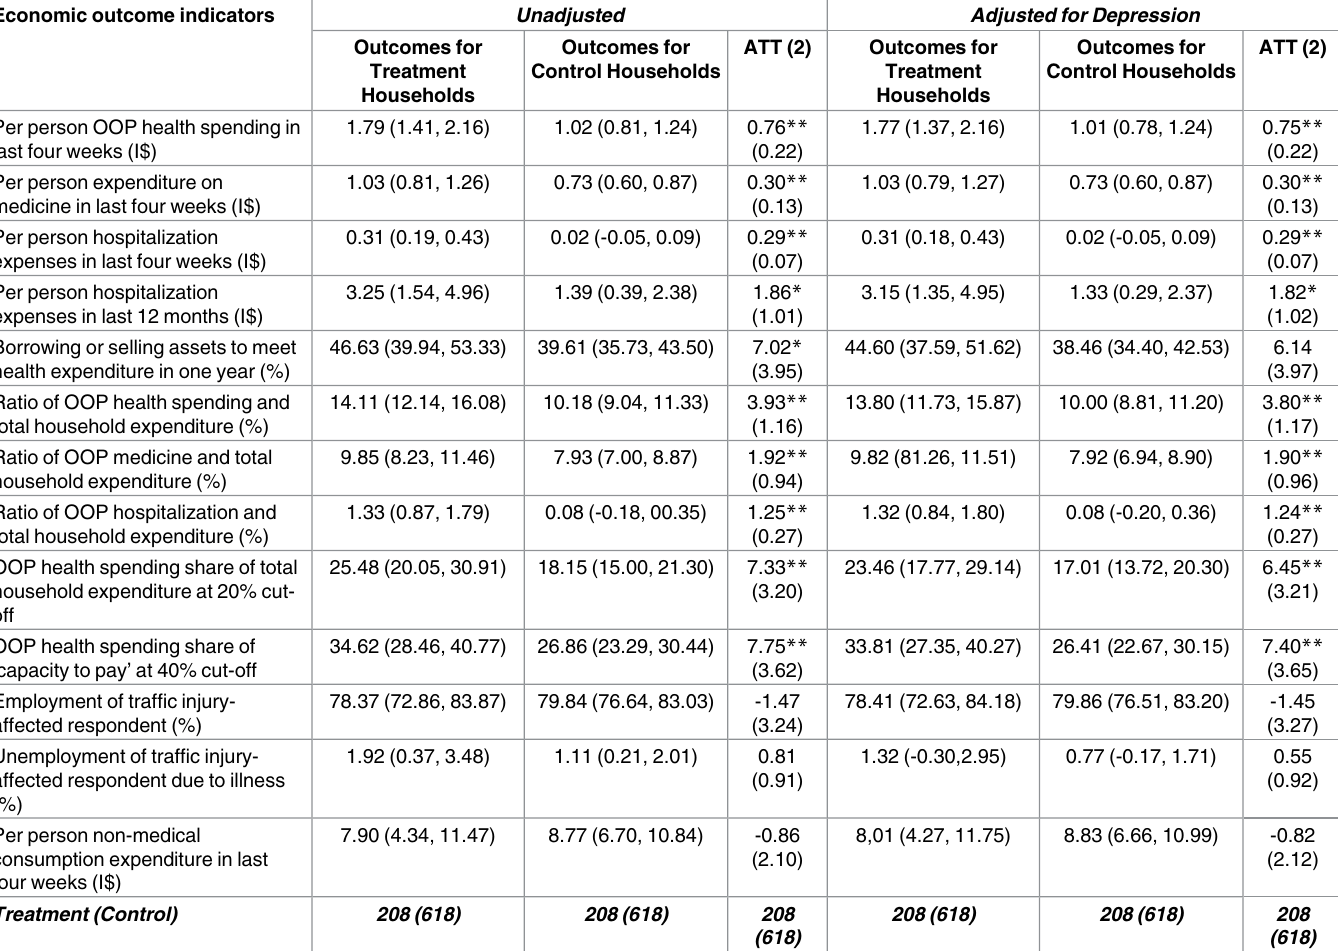
Table 2. Economic Impacts of Road Traffic Injuries on Households, South Asia, 2003: Average Treatment Effect on the Treated